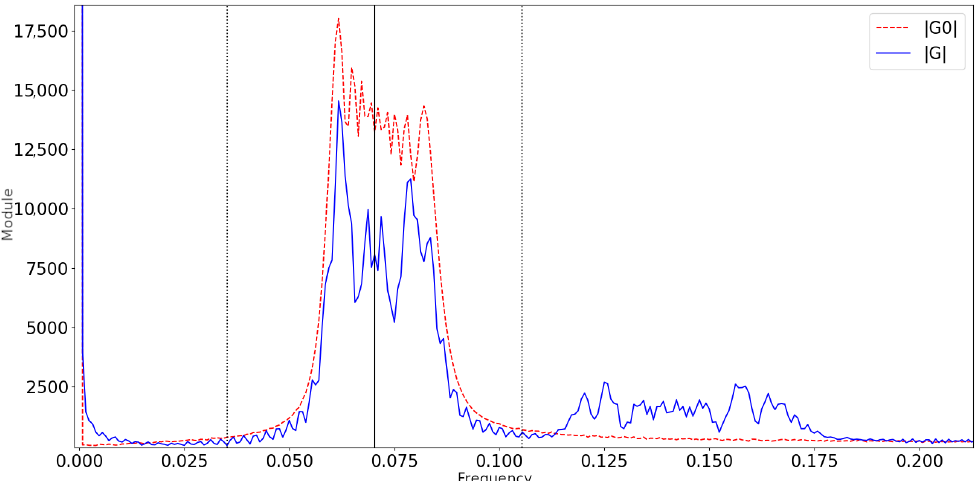
Figure 3. Module of the FFT on both reference (dotted red) and object (solid blue) images along middle row for a real dent sample. Spectrum around the fundamental frequency (solid vertical) is isolated with the automatic band-pass filter (dotted